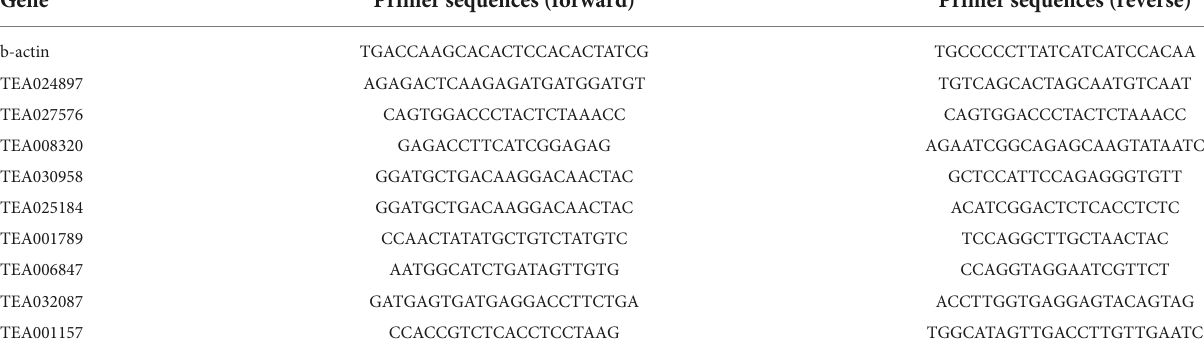
TABLE 1 Primer design for